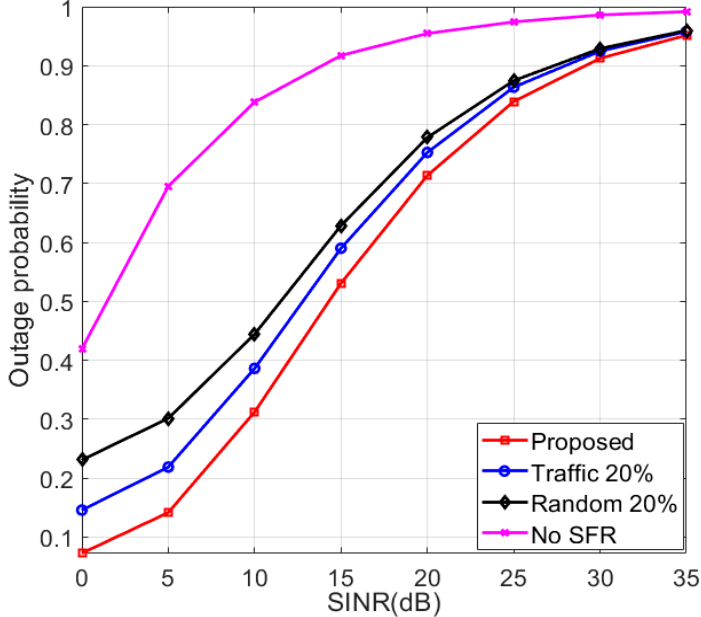
Figure 16. Outage probability for different SINR thresholds at number of UEs = 900.